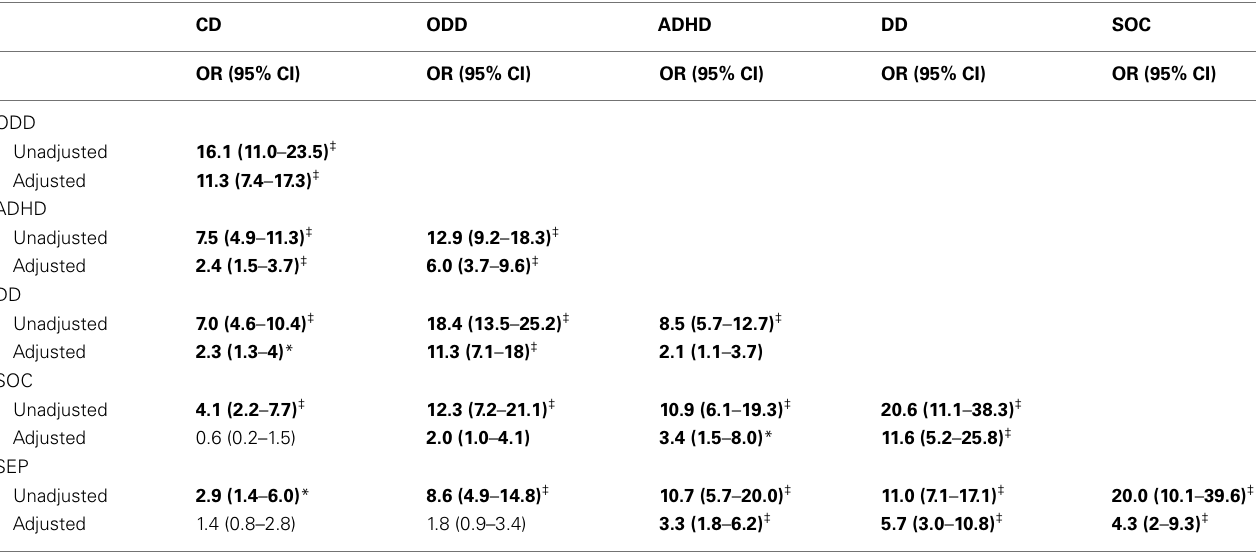
Table 3 | Unadjusted and adjusted pairwise comorbidity for common childhood diagnoses with generalized anxiety and depression grouped